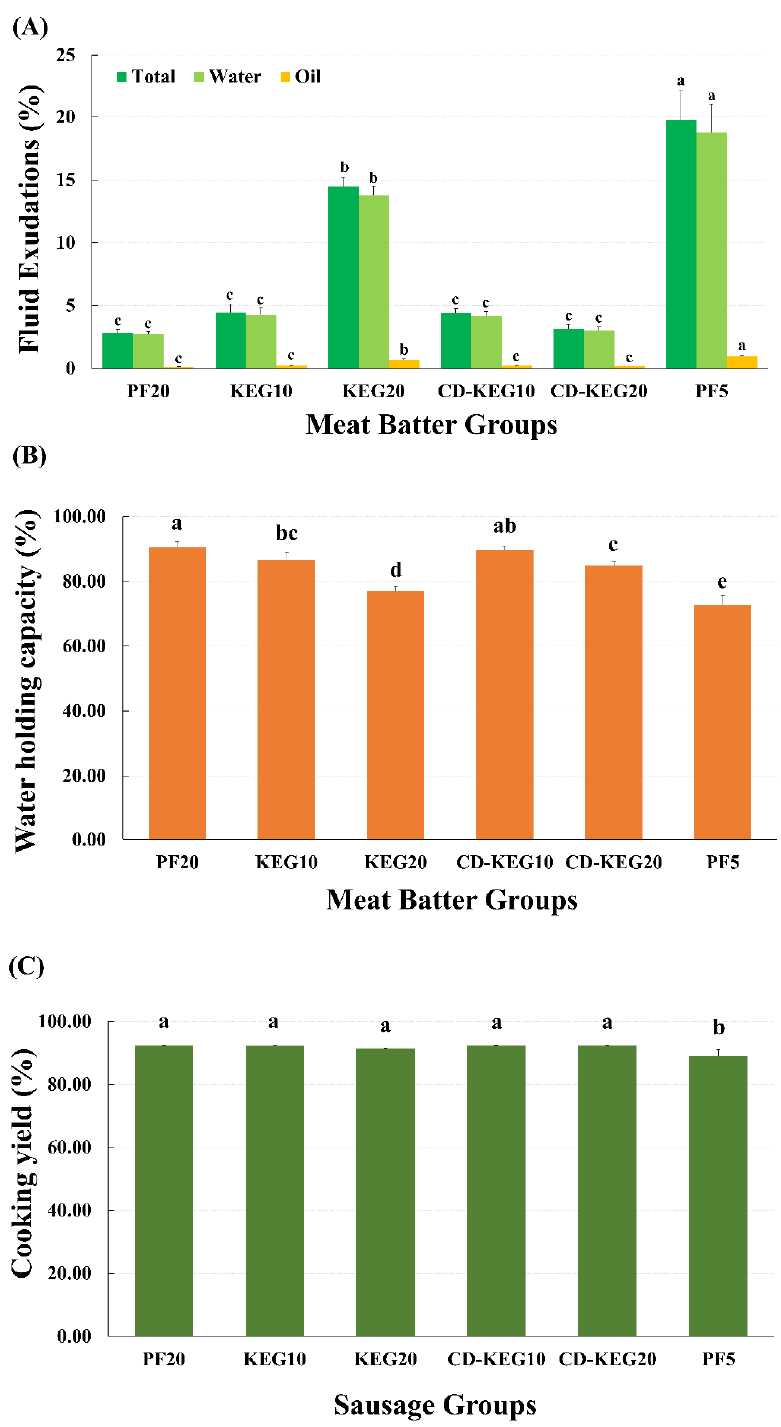
Figure 4. Emulsion stability and water holding capacity of emulsion gel-supplemented meat batter and cooking yield of emulsion gel-supplemented sausages. ( A ) Emulsion stability of meat batter, ( B ) water holding capacity of meat batter, and ( C ) cooking yield of sausages were evaluated. Emulsion stability is presented by the percentage of fluid exudation during heating. ( A ) Green, total fluid exudation (%); light green, water fluid exudation (%); orange, oil fluid exudation (%). PF20, 20% pork fat; KEG10, 10% pork fat + 10% konjac-based emulsion gel; KEG20, 20% konjac-based emulsion gel; CD-KEG10, 10% pork fat + 10% cyclodextrin (CD)-supplemented konjac-based emulsion gel; CD-KEG20, 20% CD-supplemented konjac-based emulsion gel; PF5, 5% pork fat. a–e Different letters represent a significant difference in each fluid exudation and cooking yield ( p <